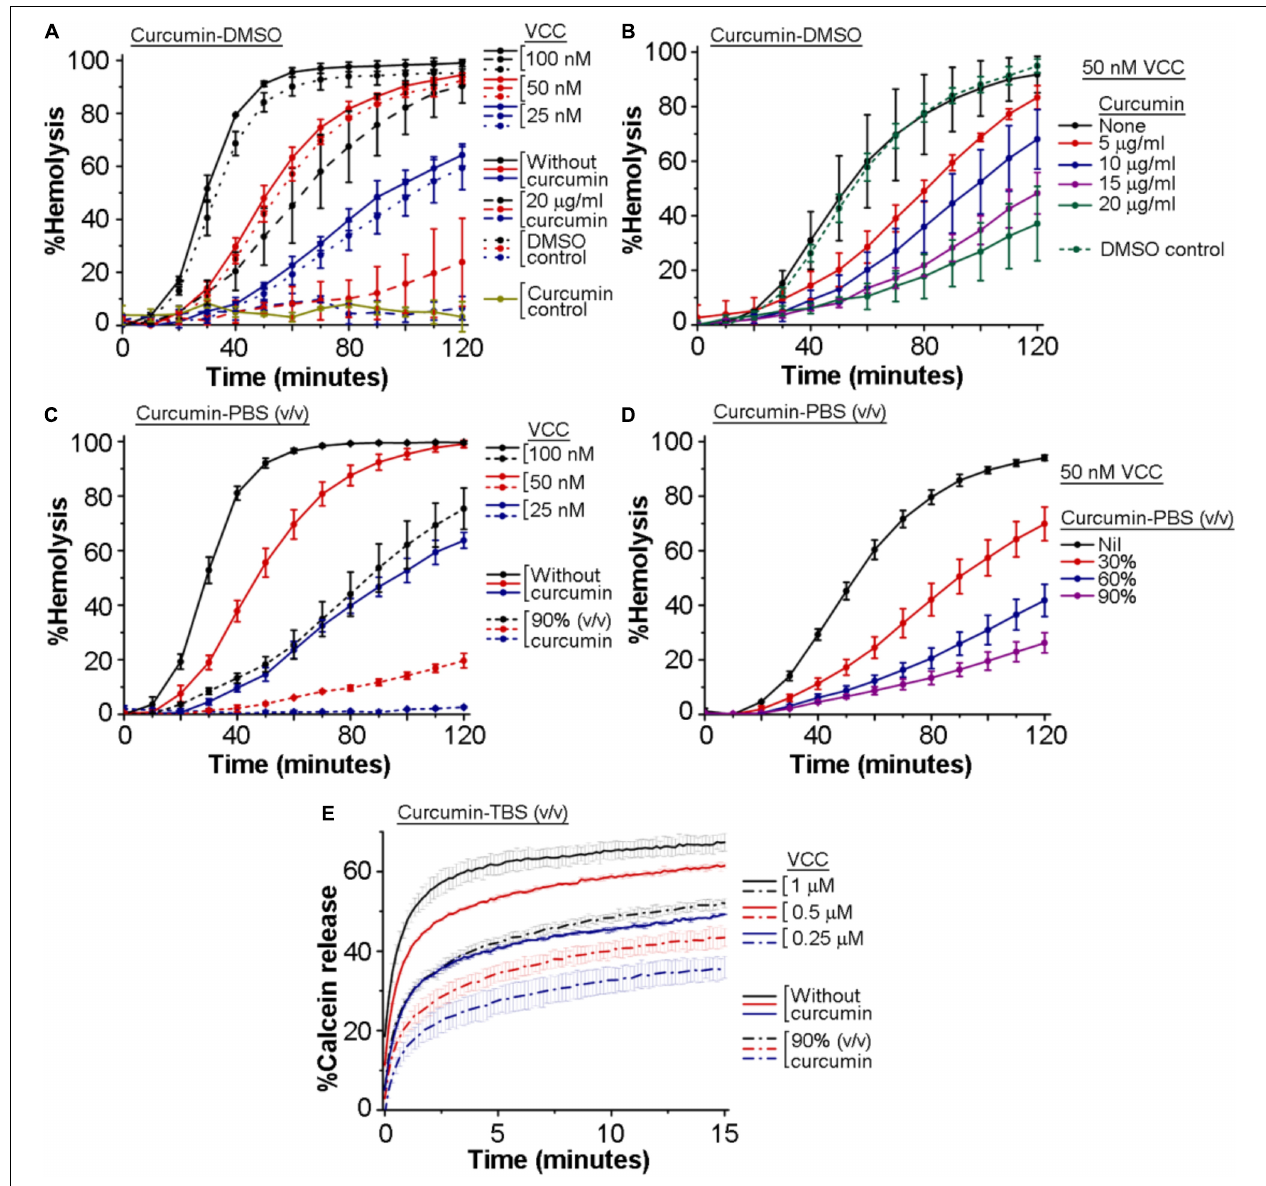
FIGURE 1 | Curcumin compromises the membrane-damaging pore-forming activity of Vibrio cholerae cytolysin (VCC). (A–D) Curcumin inhibits the pore-forming hemolytic activity of VCC against the human erythrocytes. (A,B) Hemolytic activity of VCC upon treatment with curcumin from a stock solution prepared in DMSO (curcumin-DMSO). As shown in (A) , equivalent volumes of DMSO without curcumin (denoted as the DMSO control in A ) did not affect the hemolytic activity of VCC. Also in (B) , equivalent volume of DMSO without curcumin (volume of DMSO corresponding to the treatment with 20 µ g/ml curcumin-DMSO) (designated as the DMSO control in B ) did not affect the hemolytic activity of VCC to any noticeable extent. Presence of 20 µ g/ml curcumin (added from a stock solution in DMSO) did not induce any lysis of the erythrocytes in the absence of VCC, to any noticeable extent (shown as the curcumin control in A ), suggesting that curcumin and DMSO alone do not affect the erythrocytes in the absence of the VCC treatment. (C,D) Hemolytic activity of VCC in the presence of the curcumin extract in PBS (curcumin-PBS). VCC was pre-incubated with the curcumin preparations at room temperature for 30 min before the addition of the erythrocytes. (E) Curcumin inhibits the pore-forming activity of the VCC against the membrane lipid bilayer of the Asolectin-cholesterol liposomes. VCC was pre-incubated in the presence of the curcumin extract in TBS (curcumin-TBS), at room temperature for 30 min, before the addition of the liposomes. Concentrations of VCC and curcumin shown here represent the final amount present in the reaction mixture during the hemolytic activity and the calcein-release assay. Data shown here are the averages ± standard deviations of three independent treatments.